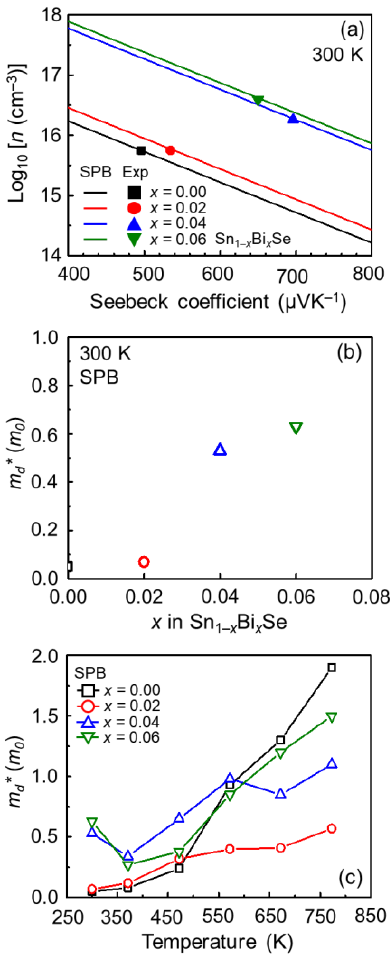
Figure 1. ( a ) Calculated (lines) and experimental (symbols) magnitude of Seebeck coefficient (| S |)- dependent log 10 ( n ) for Sn 1 − x Bi x Se ( x = 0.00, 0.02, 0.04, and 0.06) at 300 K [18], ( b ) calculated density-of-states effective mass ( m d *) varying with x in Sn 1 − x Bi x Se ( x = 0.00, 0.02, 0.04, and 0.06) at 300 K, and ( c ) calculated m d * for Sn 1 − x Bi x Se ( x = 0.00, 0.02, 0.04, and 0.06) varying with temperature (300–773